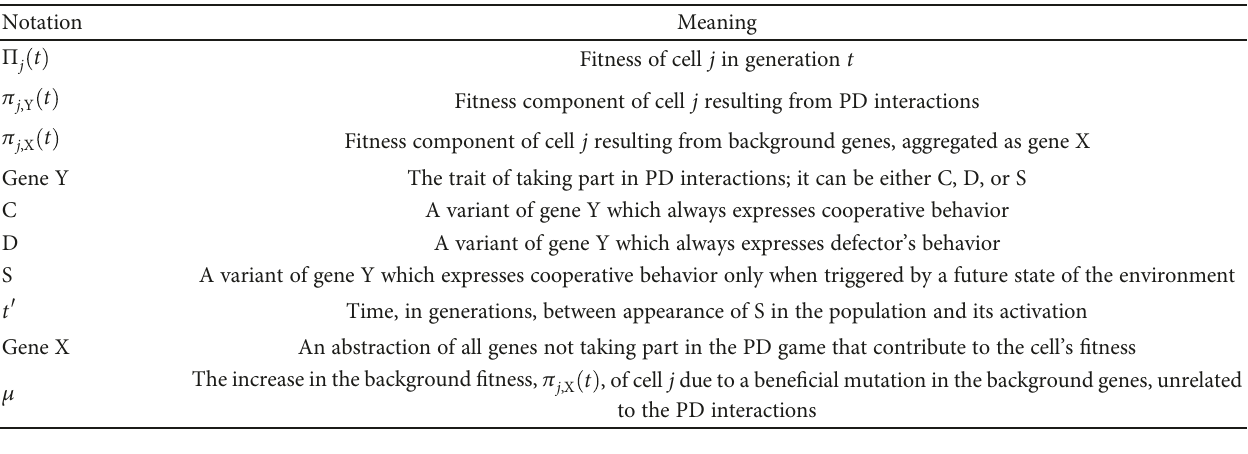
Table 3: Notation system.